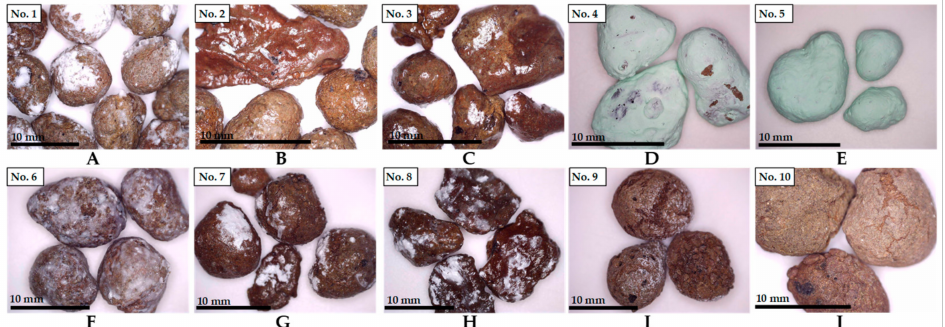
Figure 2. Expanded clay particles used in this study. ( A – H ) Particles coated with: ( A ) potassium magnesium phosphate cement; ( B , C ) one and two layers of styrene–acrylate emulsion, respectively; ( D , E ) one and two layers of waterborne, latex and acrylic-composite paint, respectively; ( F ) mag- nesium oxide and magnesium hydroxide; ( G , H ) styrene–acrylate and magnesium oxide solution, prepared with ratios 10:1 or 30:1, respectively; ( I ) uncoated control; ( J ) double-negative